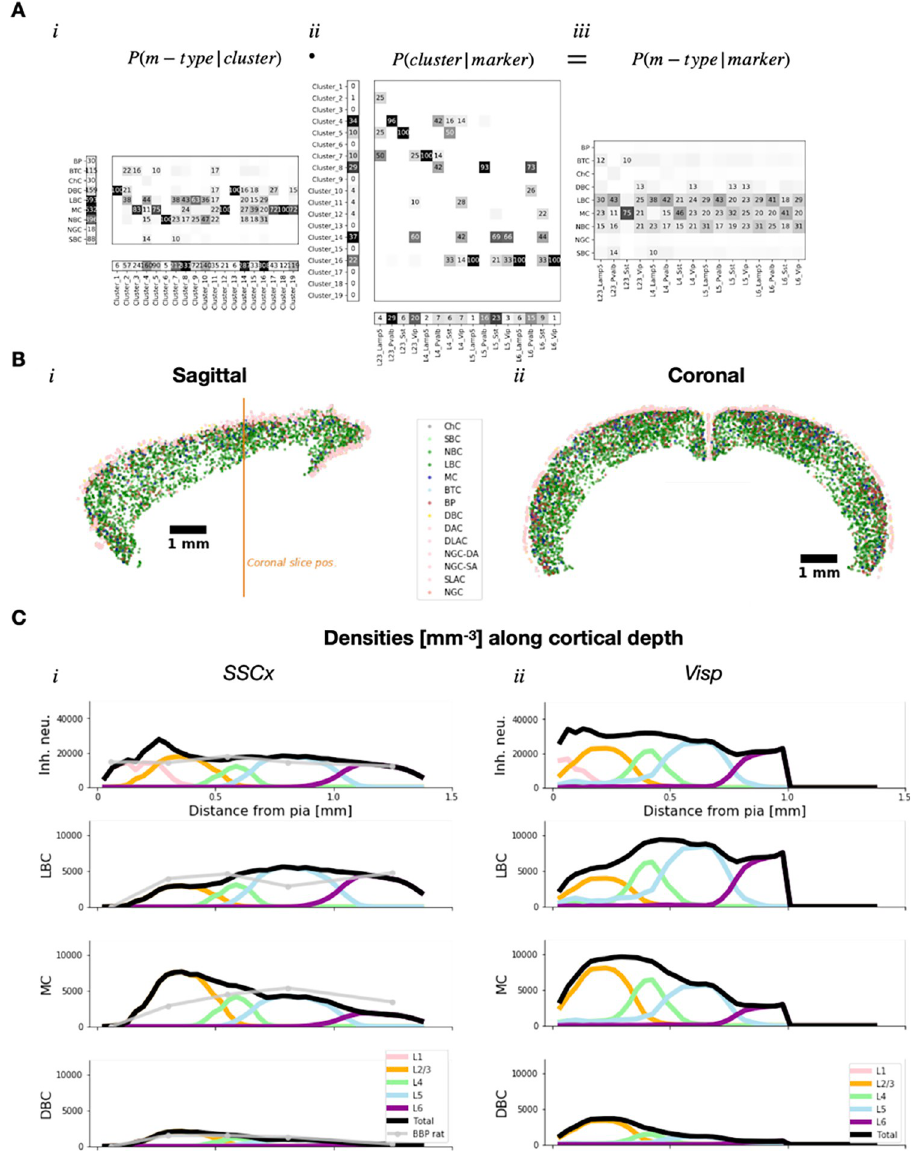
Fig 5. Estimates of BBP m-type densities using BBCAv2. A. Probability matrices to illustrate the equation used for m-type densities estimates. For clarity, P ( m-type | cluster )instead of P ( me-type | cluster )is shown in ( i ). Similarly, P ( m- type | marker ) is shown in ( iii ) instead of P ( me-type | marker ).Probability values higher than 0.1 are displayed as percentages in matrices. P ( m-type | cluster )was computed on BBP dataset in ( i ). The number of BBP me-models in each cluster is given in the bottom row, while the number of cells of each m-type is given in the first column. P ( cluster | marker ) was similarly computed on AIBS dataset in ( ii ). The number of AIBS cells in each cluster are given in the first column, while the number of cells for each AIBS molecular ID is given in the bottom row. B. Typical distribution of m- types in mouse cortex. A populator algorithm took as input cortical densities of m-types in 25 μ m wide voxels and assigned spatial coordinates to neurons in a random fashion within the same voxel. Sagittal and coronal view of inhibitory neuron distributions are color-coded by m-types. Orange vertical bar in i shows the position of the coronal slice. C. BBP m-types densities along cortical depth computed by applying the P ( m-type | marker )matrix to marker densities from the BBCAv2. Two different cortical areas are displayed: primary somatosensory cortex, hindlimb area (SSCx, i ) and primary area in visual cortex (Visp, ii ). Densities of all inhibitory neurons are shown in the first row and only LBC, MC and DBC m-types are shown for clarity (all m-types are available in S3 Fig). Other m-types and me- types are similarly computed. Contributions per layer are shown as colored lines while the total is displayed in black. For comparison in somatosensory cortex, data from rat neocortical microcircuitry reconstruction are shown in light grey.